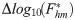
Drug-induced shifts in the location parameters of the reward mountain.The Δlog10(Fhm*) values give the shifts of the reward-growth function and reward mountain along the pulse-frequency axis, whereas the Δlog10(Pobje*) values give the shifts along the price axis. These values have been corrected for the estimated change in frequency-following fidelity due to the drug-induced displacement of the reward mountain along the pulse-frequency axis. According to the reward-mountain model, the Δlog10(Fhm*) values reflect action of the dopamine transporter blocker prior to the input to the reward-growth function, whereas the Δlog10(Pe*) values reflect drug action at, or beyond, the output of the reward-growth function. Δlog10(Fhm*) is shorthand for Δlog10(Fpulsehm*).